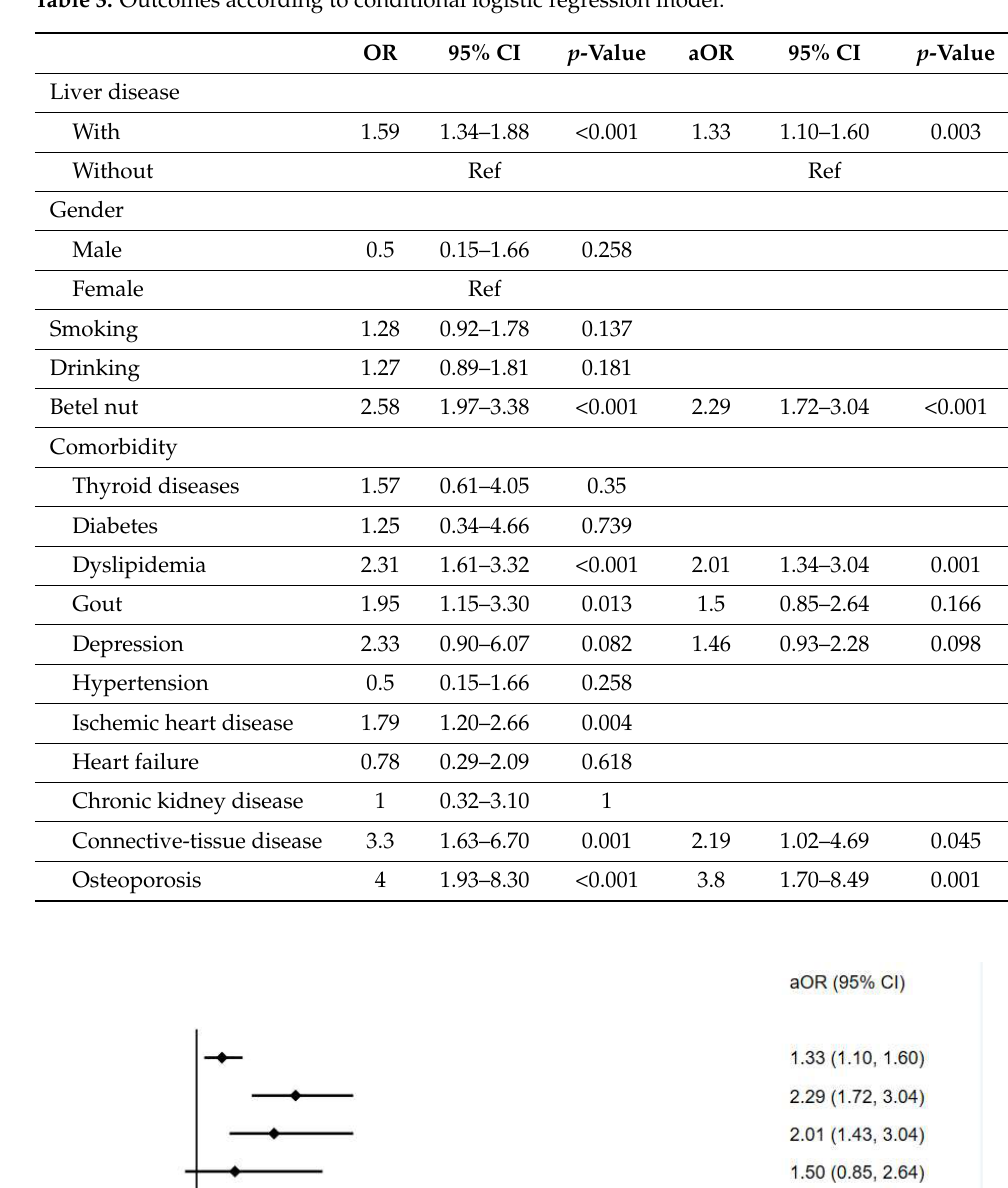
Table 3. Outcomes according to conditional logistic regression model.